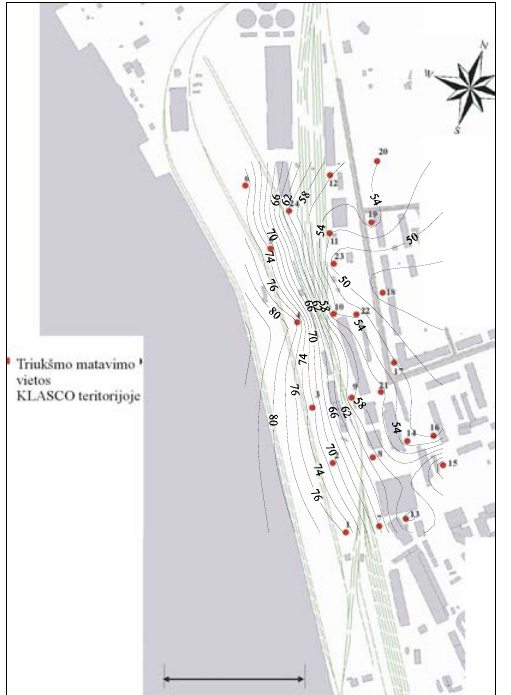
11 pav. Ekvivalentinio triukšmo lygio sklaida nakt į spalio m ė n. Fig 11. Dispersion of reciprocal noise level at night in Oc- tober